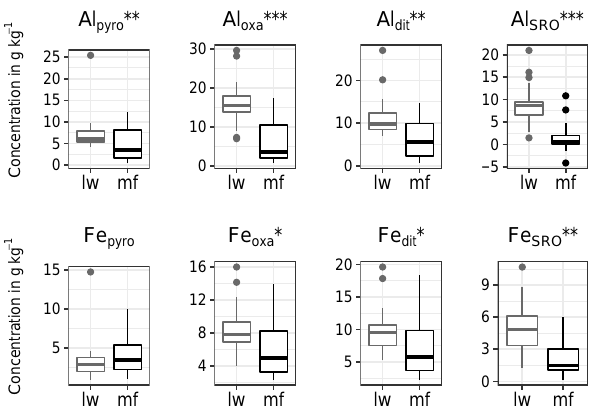
Figure 5. Distribution of Fe and Al species concentrations in the B horizon of lw and mf plots. Boxplots represent the distri- bution around the median values. “Pyro”, “oxa” and “dit” sub- scripts mention the type of extractions used for isolating Fe and Al species (respectively pyrophosphate, oxalate and dithionite– citrate). “SRO” stand for short-range order species (Al SRO = Al oxa - Al pyro , Fe SRO = Fe oxa -Fe pyro ) . Asterisks indicate a significant dif- ference using mixed models (see Materials and methods), with ∗ p value<0.05, ∗∗ p value<0.01 and ∗∗∗ p